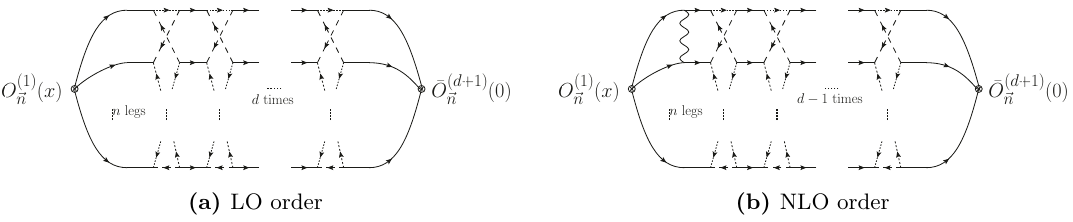
. The NLO includes all the ways of ~n